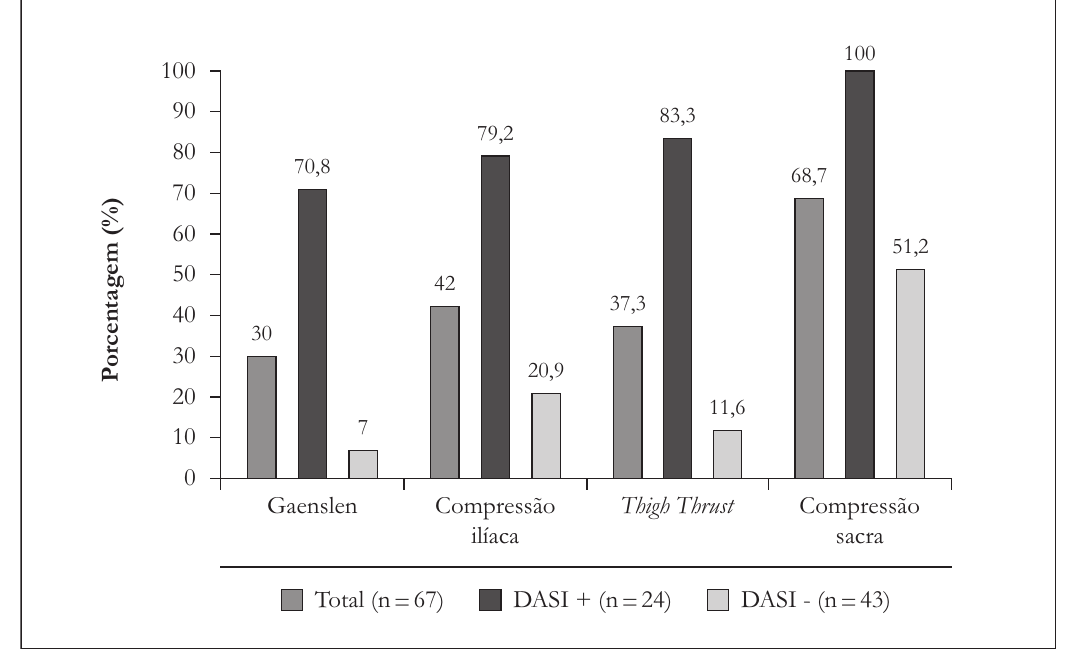
Figura 2 - Porcentagem de registros positivos nas provas de provocação de dor. Para cada prova é apresentada a porcentagem de registros positivos para a amostra total do estudo,